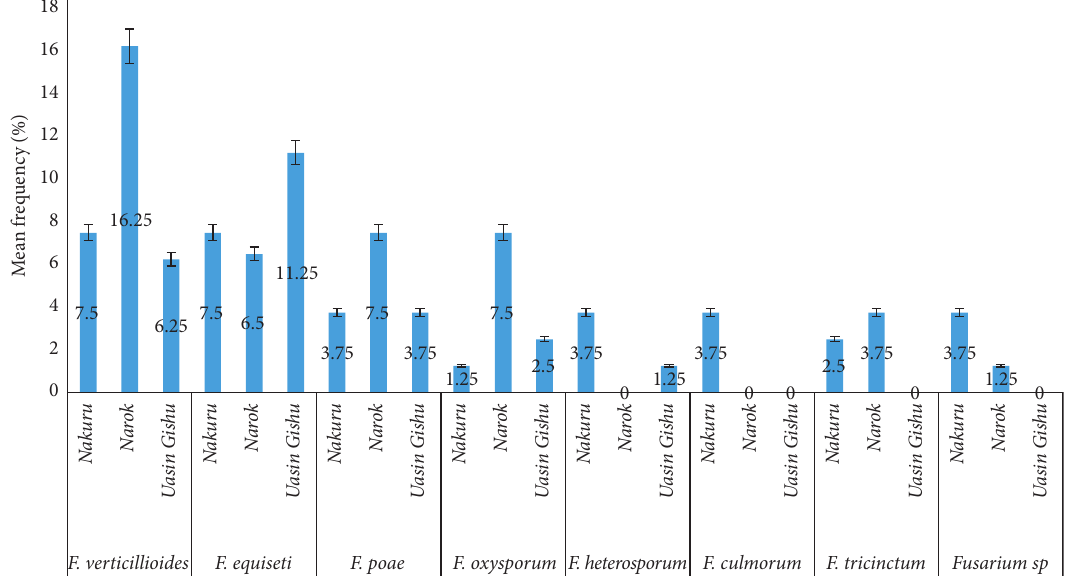
F. oxysporum F. heterosporum F. culmorum F. tricinctum Figure 4: Means on prevalence of pathogenic Fusarium spp. in genotypes of wheat seeds at harvest time in three Rift Valley regions,